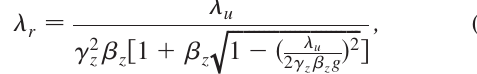
FIG. 1. (Color) Schematic layout of a PPW THz FEL employing and (cid:2) are the PhC’s cell size 1D PhC outcoupler mirror. (cid:2) PC u and undulator period, respectively. A relativistic electron beam pulse is injected from the side into the PPW. Use of a metal- lodielectric high-reflection (HR) mirror [31–33] is optional for a FEL cavity. In the case of an external THz pulse stacker cavity where HR mirror reflectivities in excess of 99.9% are needed, it helps to reduce the number of the cells required inside the